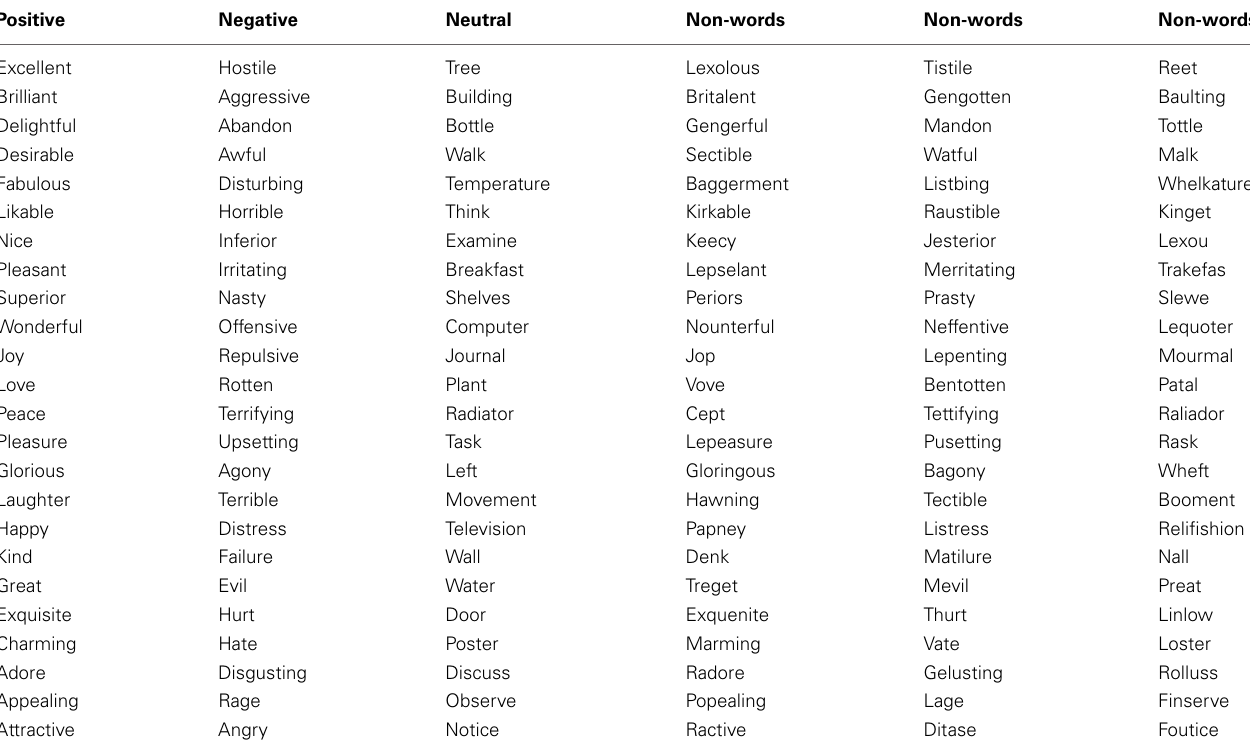
Table 1 | Pre-election word